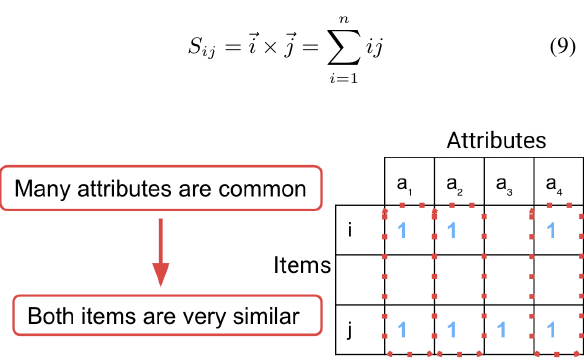
Figure 5. Scenario case for dot product similarity metrics.